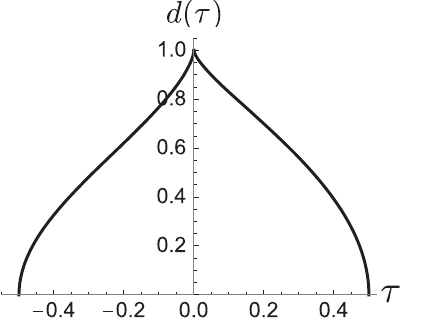
0 as a function of τ . p x ¼ y ¼